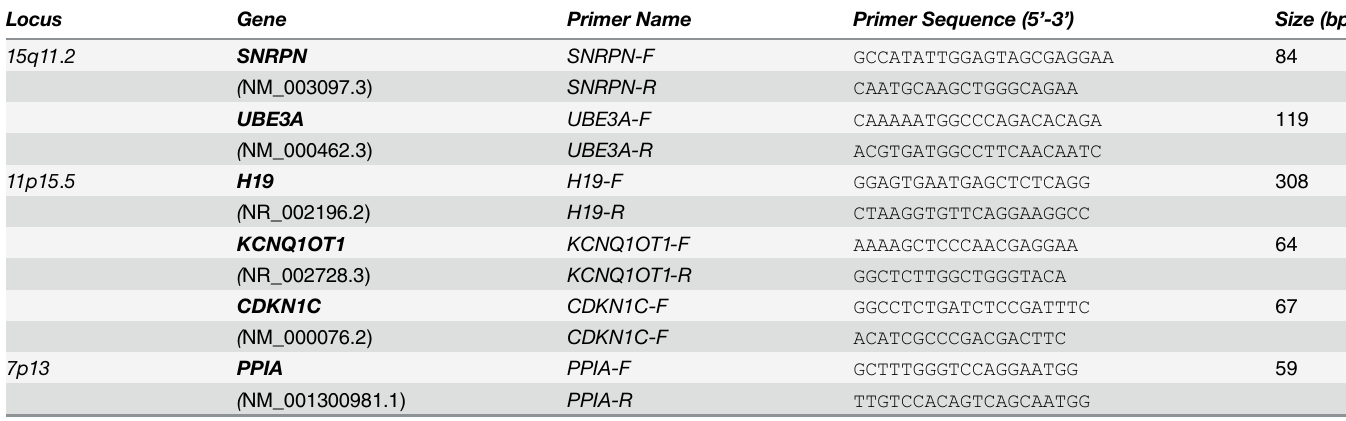
Table 3. Expression primers and PCR parameters.